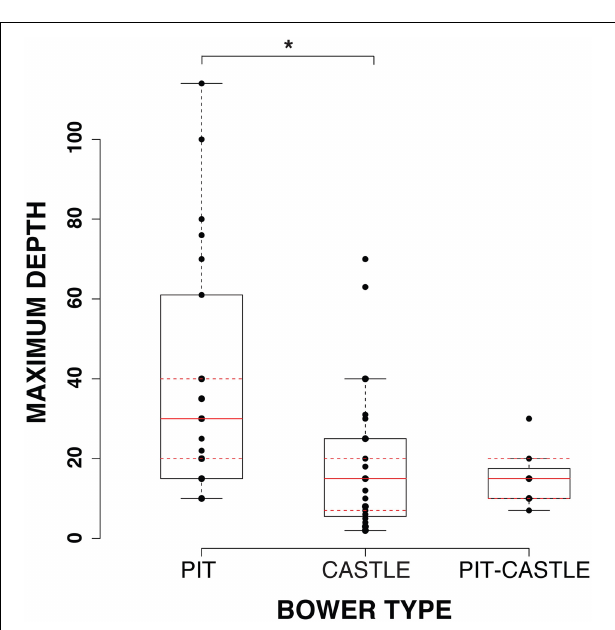
FIGURE 3 | Depth differences between bower types. Boxplot of 1-Way ANOVA results shows significant differences in maximum depth between pit, castle, and pit-castle species. ∗ p < 0 .